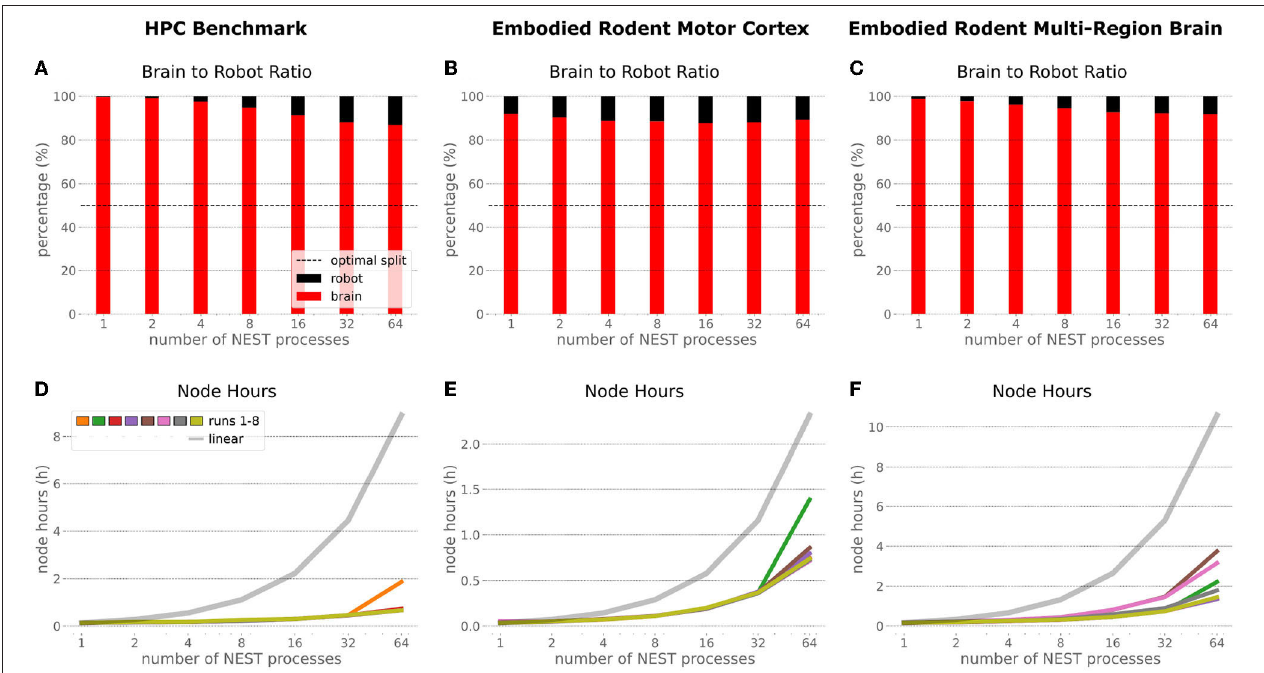
FIGURE 13 | Comparison of benchmark experiments. Brain to Body step time ratio (mean values over all 8 benchmark repetitions) and node hours required to run the simulation for the HPC Benchmark, embodied rodent brain experiment with Motor cortex only and full embodied multi-region rodent brain experiment. For all experiments the brain execution takes longer than the robot simulation step (A–C) . This imbalance can be improved with our distributed architecture in particular for large neural networks as with the HPC Benchmark (A) and full embodied multi-region rodent brain experiment (C) . The required amount of node hours to run the experiments does not scale up linearly, it increases exponentially with small slope only. The embodied multi-region rodent brain experiment (F) requires the most node hours, but the required node hours increase by factors about less than 14, 35 and 23 for the HPC Benchmark (D) , embodied rodent brain experiment with only Motor cortex (E) and full embodied multi-region rodent brain experiment (F) ,